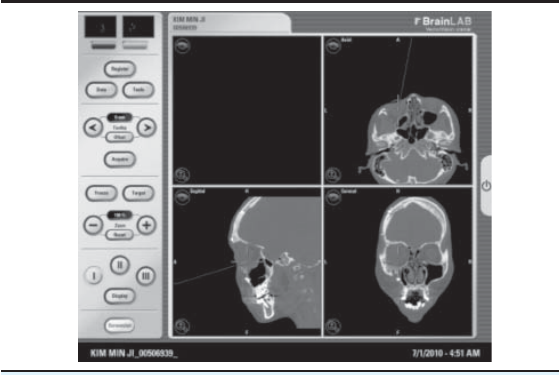
Figure 4. Secondary reconstruction for enophthalmos- intraoperative navigation. The criss-cross (green color) in the monitor which